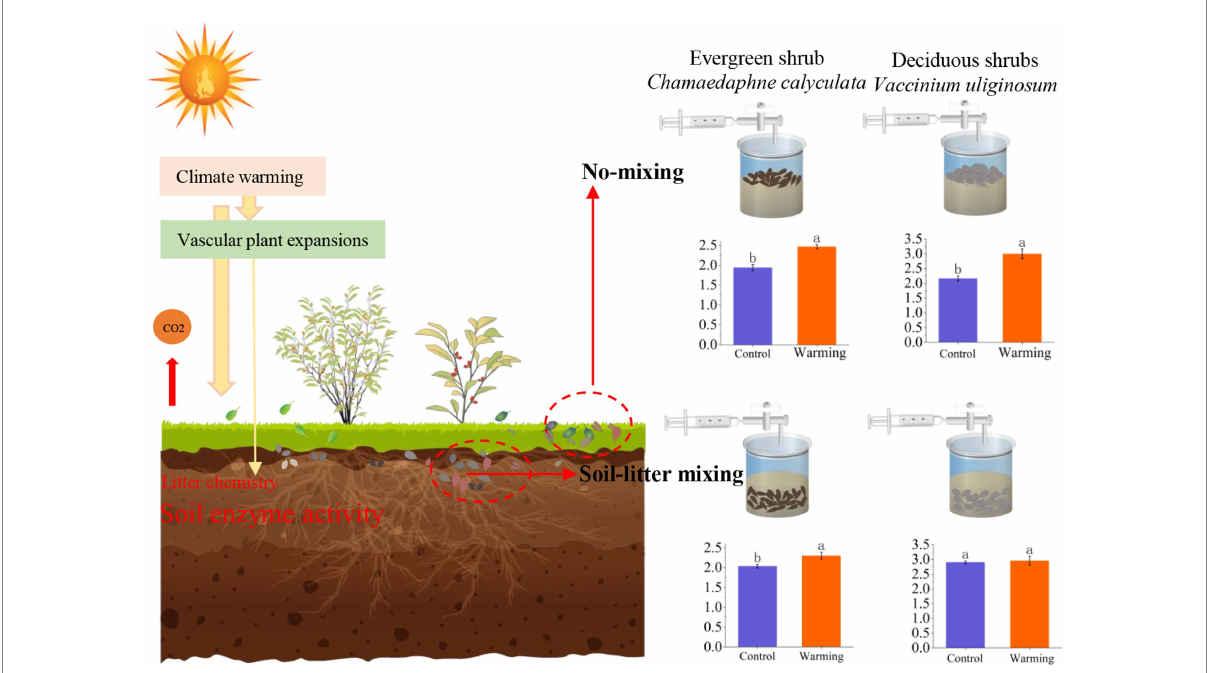
FIGURE 5 A mechanism framework for the response of leaf litter decomposition to warming at different positions. The two plants in the left half of the figure represent plants C. calyculata and V. uliginosum . The two red dashed boxes, from left to right, represent litter mixed with soil (Soil-litter mixing) and litter on the soil surface (No-mixing), respectively. The bar graphs in the right half of the figure shows the average CO 2 emission rate throughout the incubation period, under the different treatments (the different letters in the insets represent statistical differences ( p < 0.05) based on a Tukey’s multiple comparison